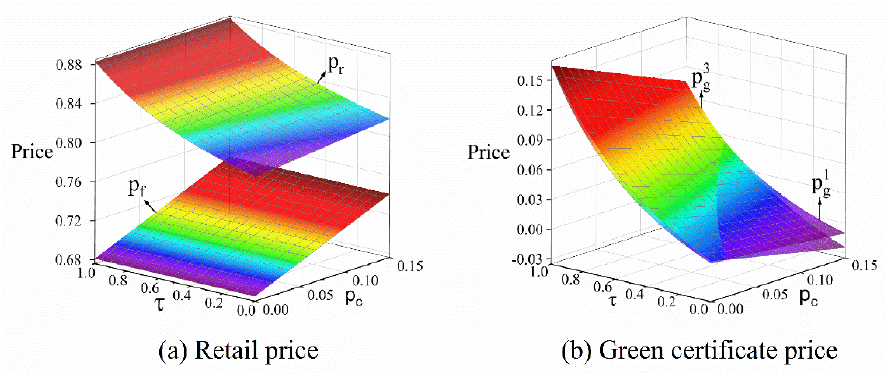
Figure 8. The trend of the price under different levels of τ and p c .